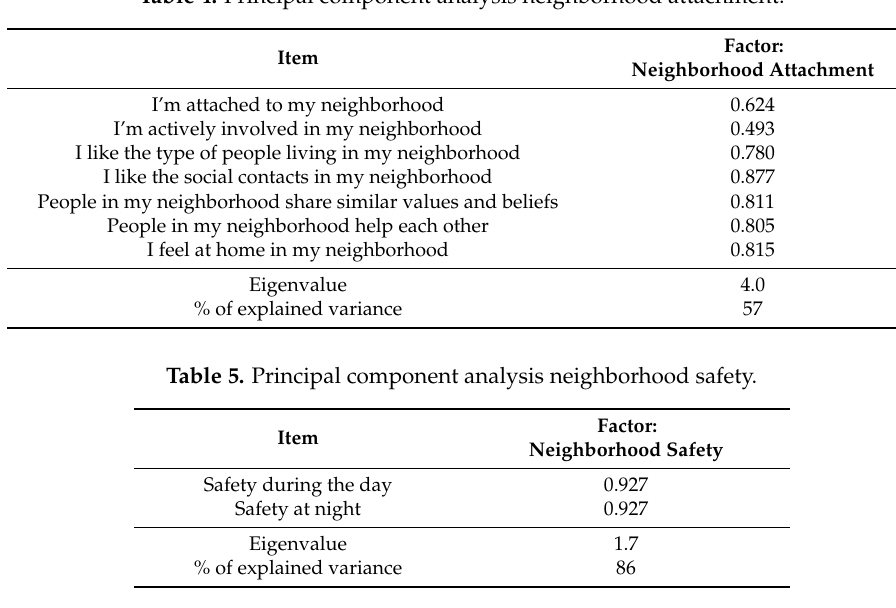
Table 4. Principal component analysis neighborhood attachment.